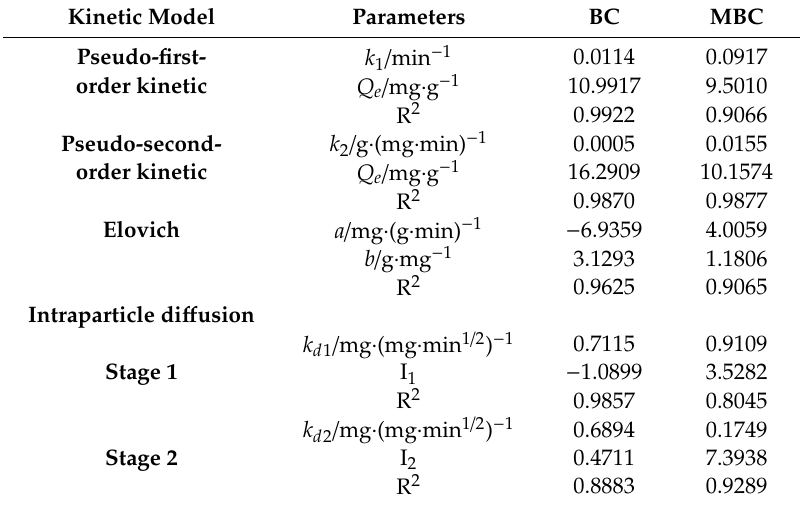
Table 4. Fitting parameters of four kinetic models for adsorption of BPA onto BC and